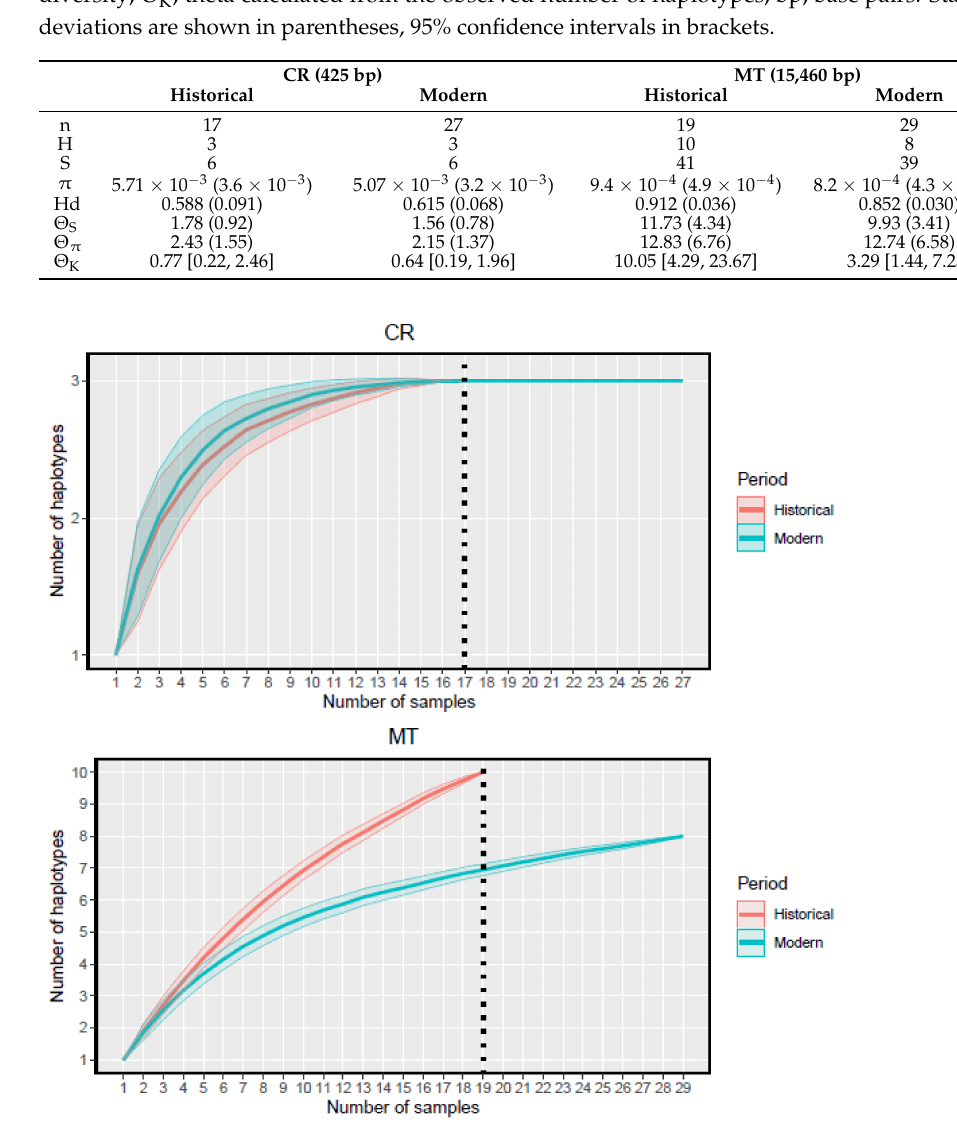
Figure 2. Haplotype accumulation for control region (CR) and near-complete mitochondrial DNA sequences (MT) for historical (red) and modern Iberian wolves (blue). Average estimated from 1000 randomizations. Color dashed lines and filled area indicate standard error. Vertical black dashed line indicates the lowest number of sequences sampled for each